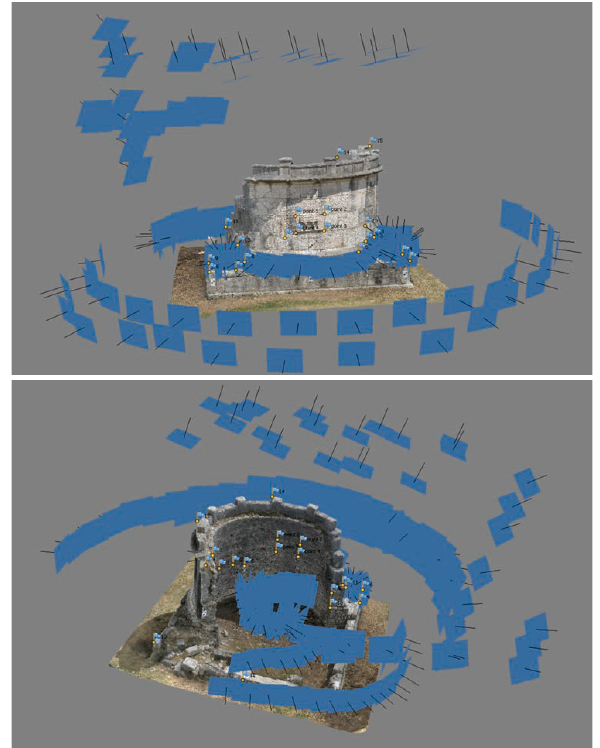
Figure 3. Photogrammetric model of C. E. Marsus's mausoleum